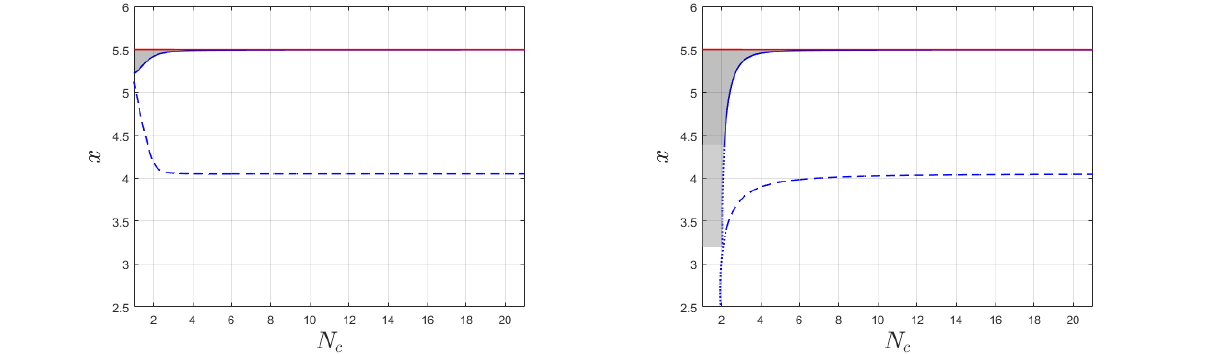
Figure 21. Two options for the conformal window. Solid blue lines: lower edge of the conformal window through annihilation of the Banks-Zaks (cid:12)xed point with another (cid:12)xed point QCD*. Dashed blue line: lower edge of the conformal window in the model without Yukawa interaction. Red line: upper edge of the conformal window, where the Banks-Zaks (cid:12)xed point obtains non-trivial positive gauge coupling. Shaded region: conformal window. Light shaded region: region where the Banks- Zaks and the QCD* (cid:12)xed point diverge instead of